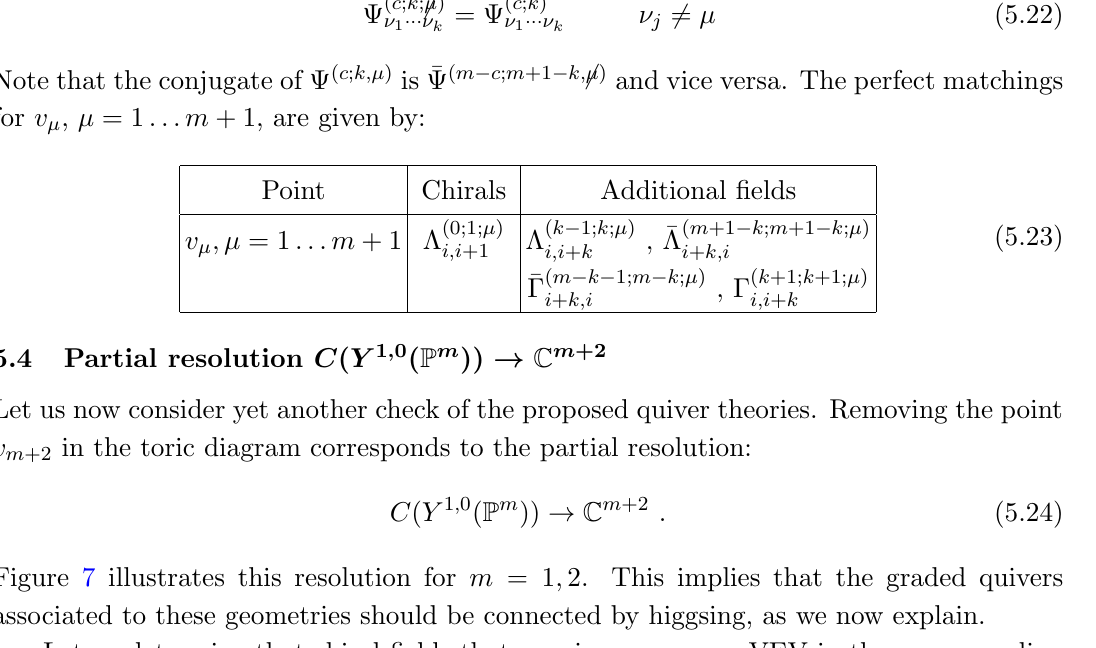
Figure 7. C ( Y 1 ; 0 ( P m ))